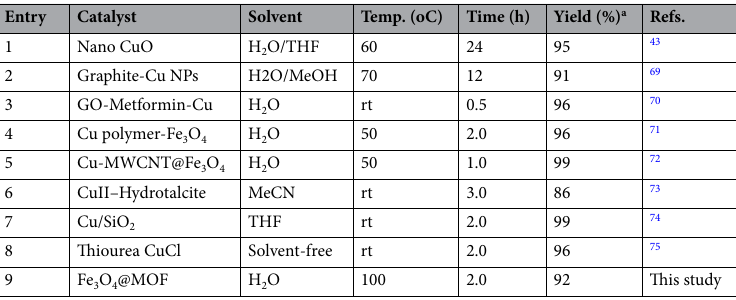
Table 3. Comparison of Fe 3 O 4 @HKUST-1 catalyst with other copper catalysts for the synthesis of 1,2,3-triazole 4a. a Based on isolated yield.